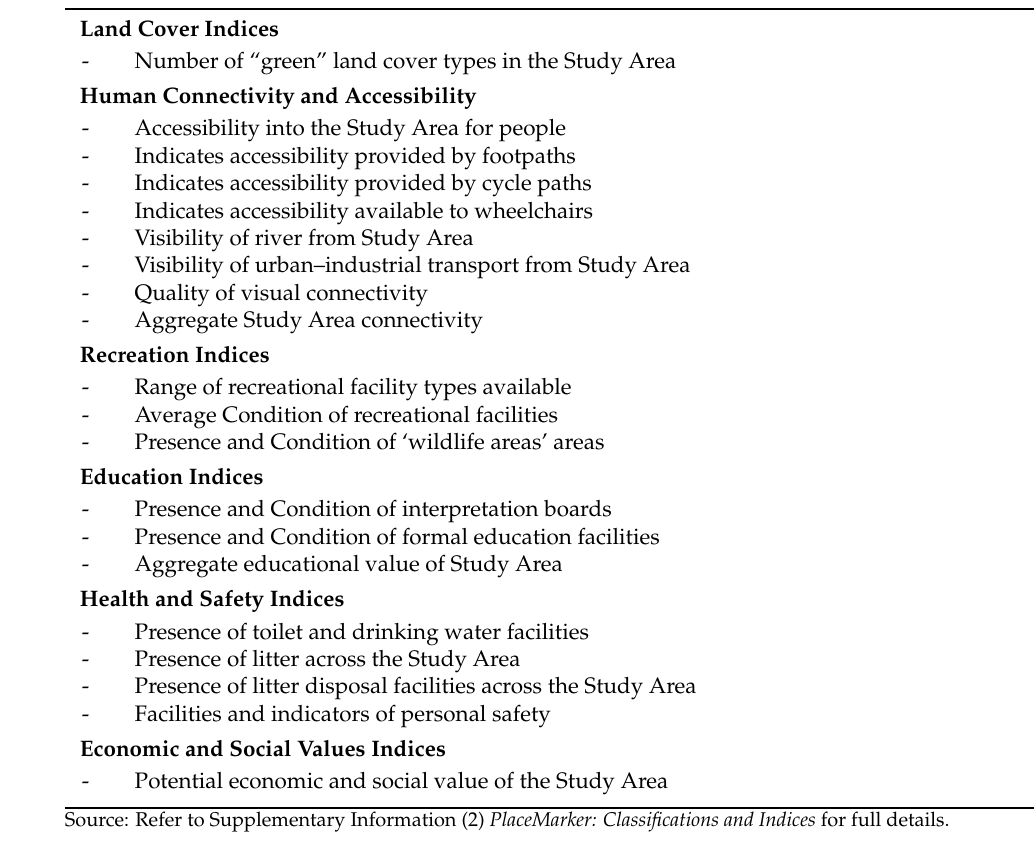
Table 3. PlaceMarker Study Area indices.